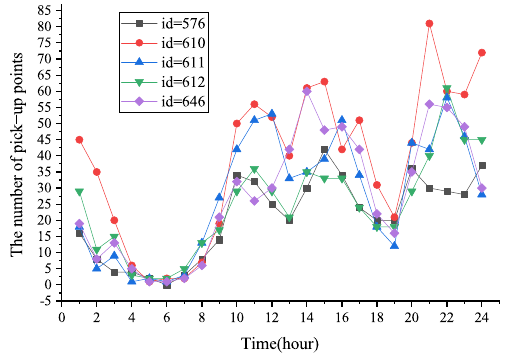
Figure 3. Traffic passenger flows at different times of the day in adjacent grids.